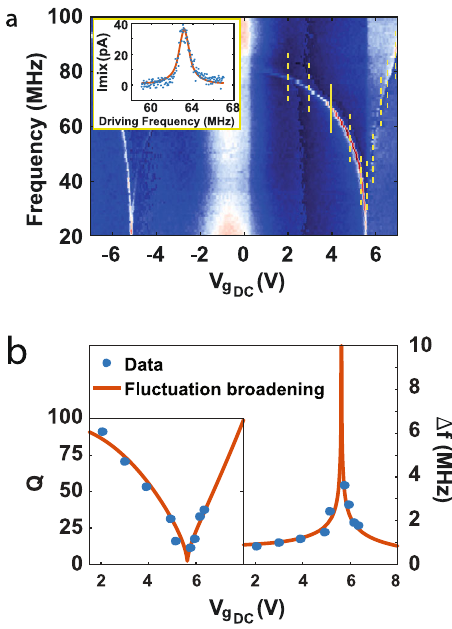
Fig. 4 | Spectral broadening at room temperature. a Resonance frequency measurement of device IX in the third category, whereb c ≤ b 0 <0.The yellow lines represent the frequency cross sections from which the data in ( b ) were extracted. Insetisanexampletakenattheyellowsolidline.Bluedotsarethedata,orangesolid lineisaLorentzianshape fi t. b Qualityfactor(left)andspectralbroadening(FWHM, right) extracted from ( a ) vs thestaticgate load(blue dots). The orange solid line is the theoretical calculation based on Eq. 1. The excellent fi t implies that fl uctuation broadening is the most signi fi cant mechanism to cause the low Q evidenced at room